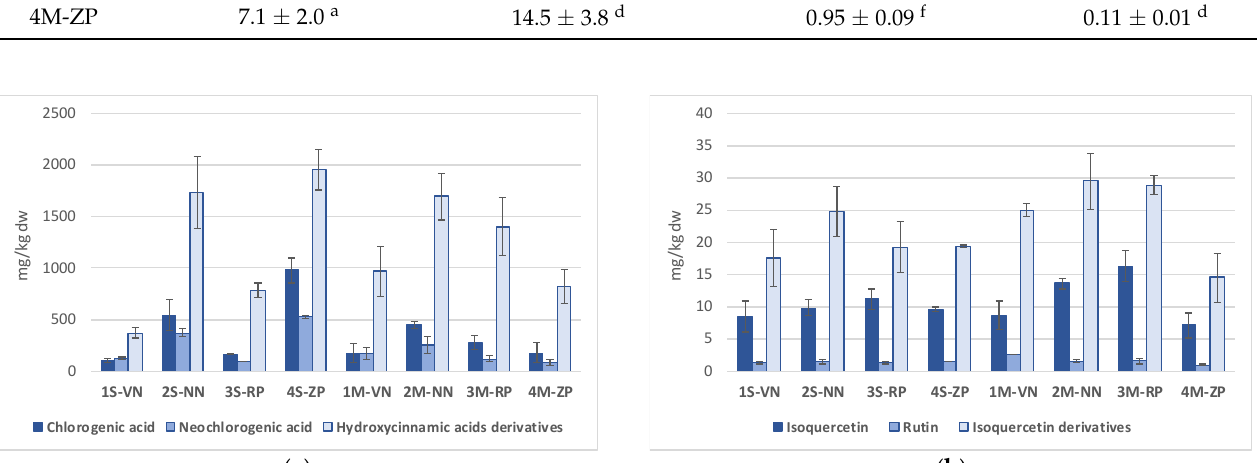
Figure 1. HPLC-ESI-MS chromatogram of hydroalcoholic extracts (MeOH/H 2 O; 80:20%, v/v ) of sam- ple 1S-VN.